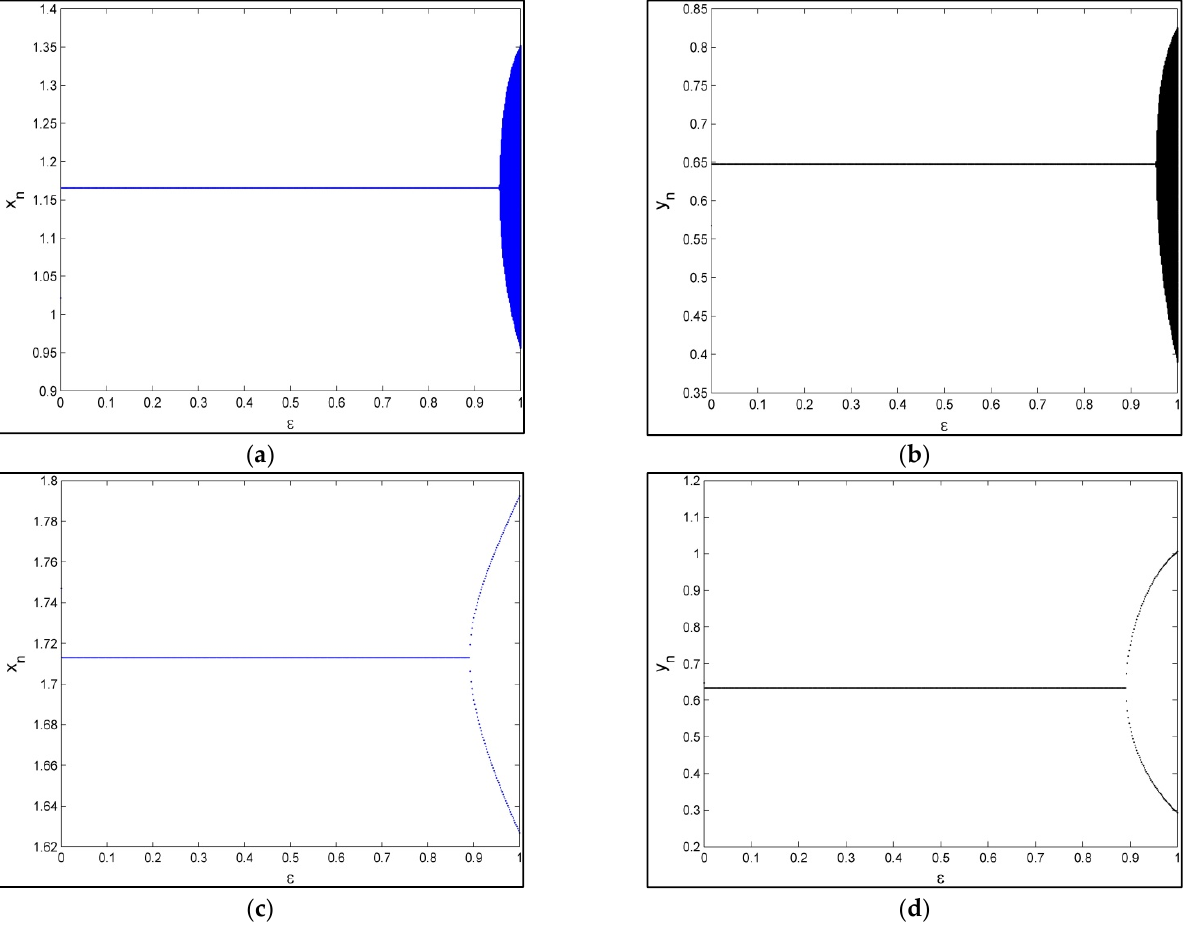
Figure 4. ( a ) Bifurcation diagrams of x n for controlled system (28), ( b ) bifurcation diagrams of y n for controlled system (28), ( c ) bifurcation diagrams of x n for controlled system (30), and ( d ) bifurcation diagrams of y n for controlled system